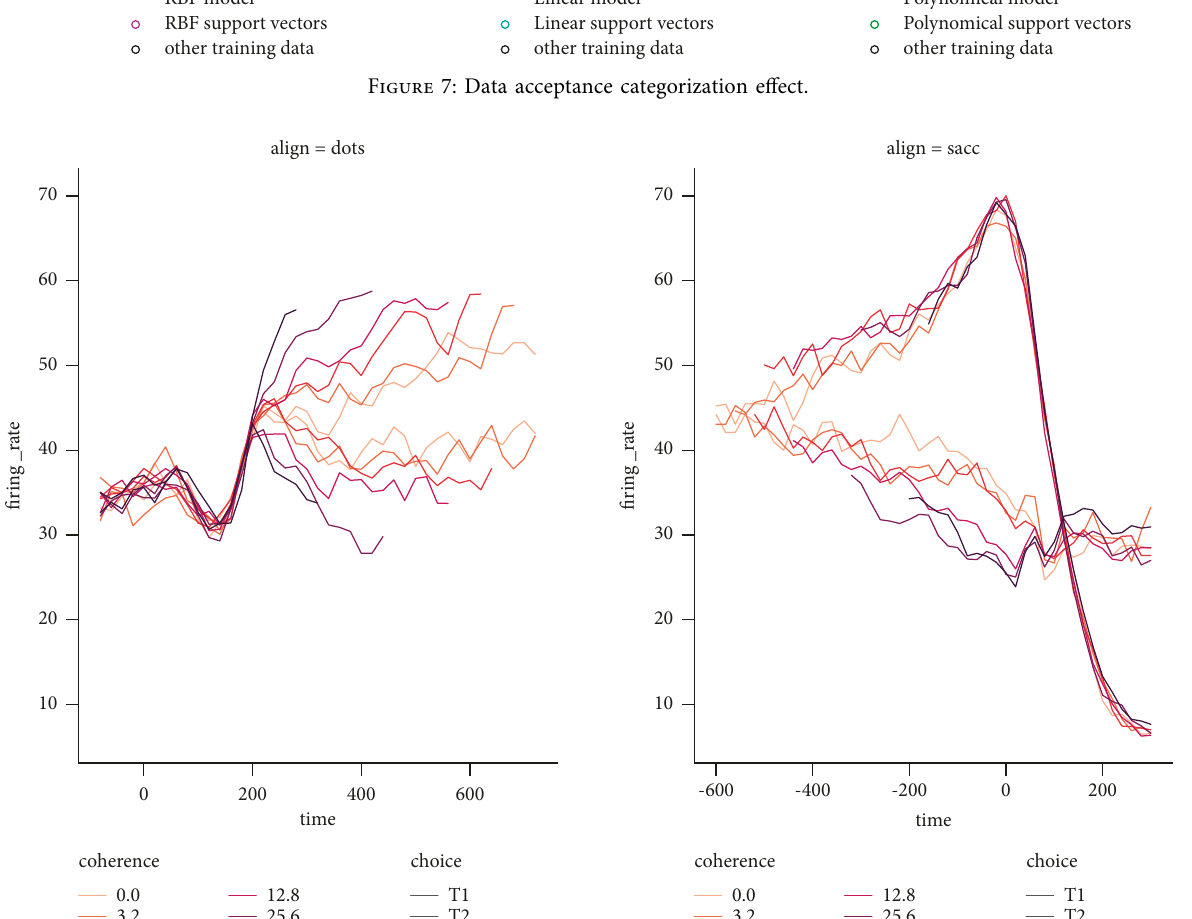
Figure 8: Effect of integration of different sports